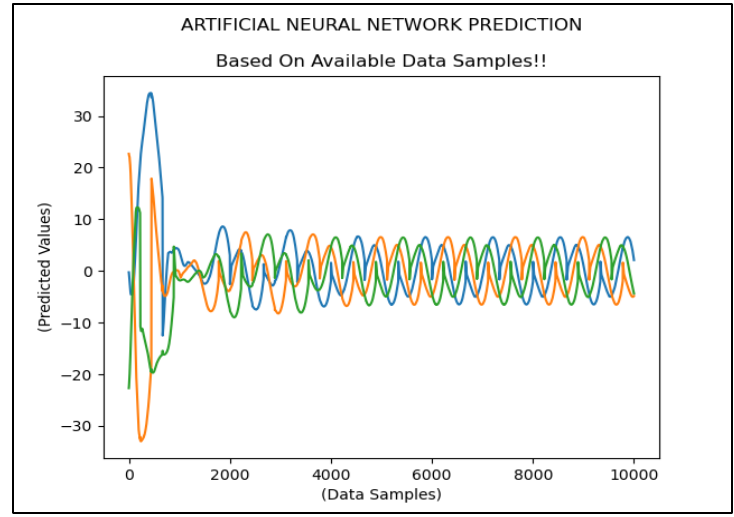
Figure 32. Output (Reference current) From ANN control algorithm.